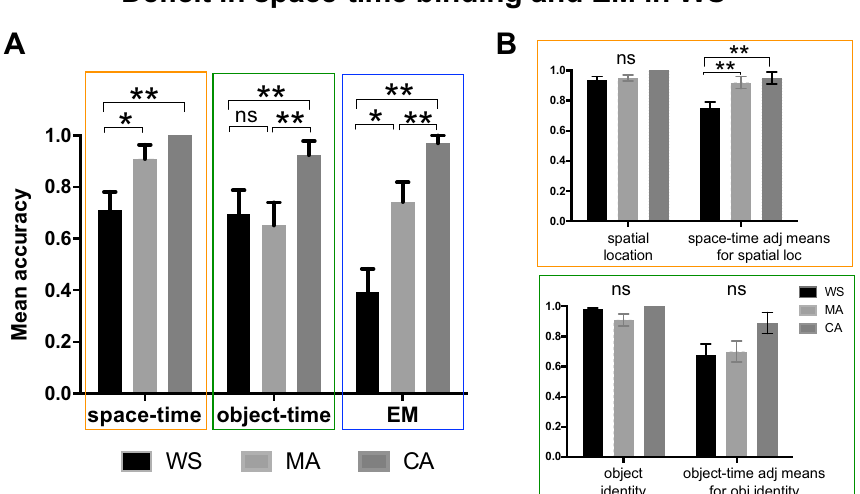
Figure 2. Deficit in space-time binding and full EM in Williams Syndrome. ( A ) The graphs represent the accuracy means for Space-Time, Object-Time and EM tests in WS patients, compared to MA and CA controls. ( B ) The graphs present the mean accuracies for spatial location and space-time binding adjusted for spatial location performance (above), and for object identity and object-time binding adjusted for object identity accuracy (below). Adjusted means were calculated using GZLM. ns = not significant. p < 0.05 *, p < 0.01